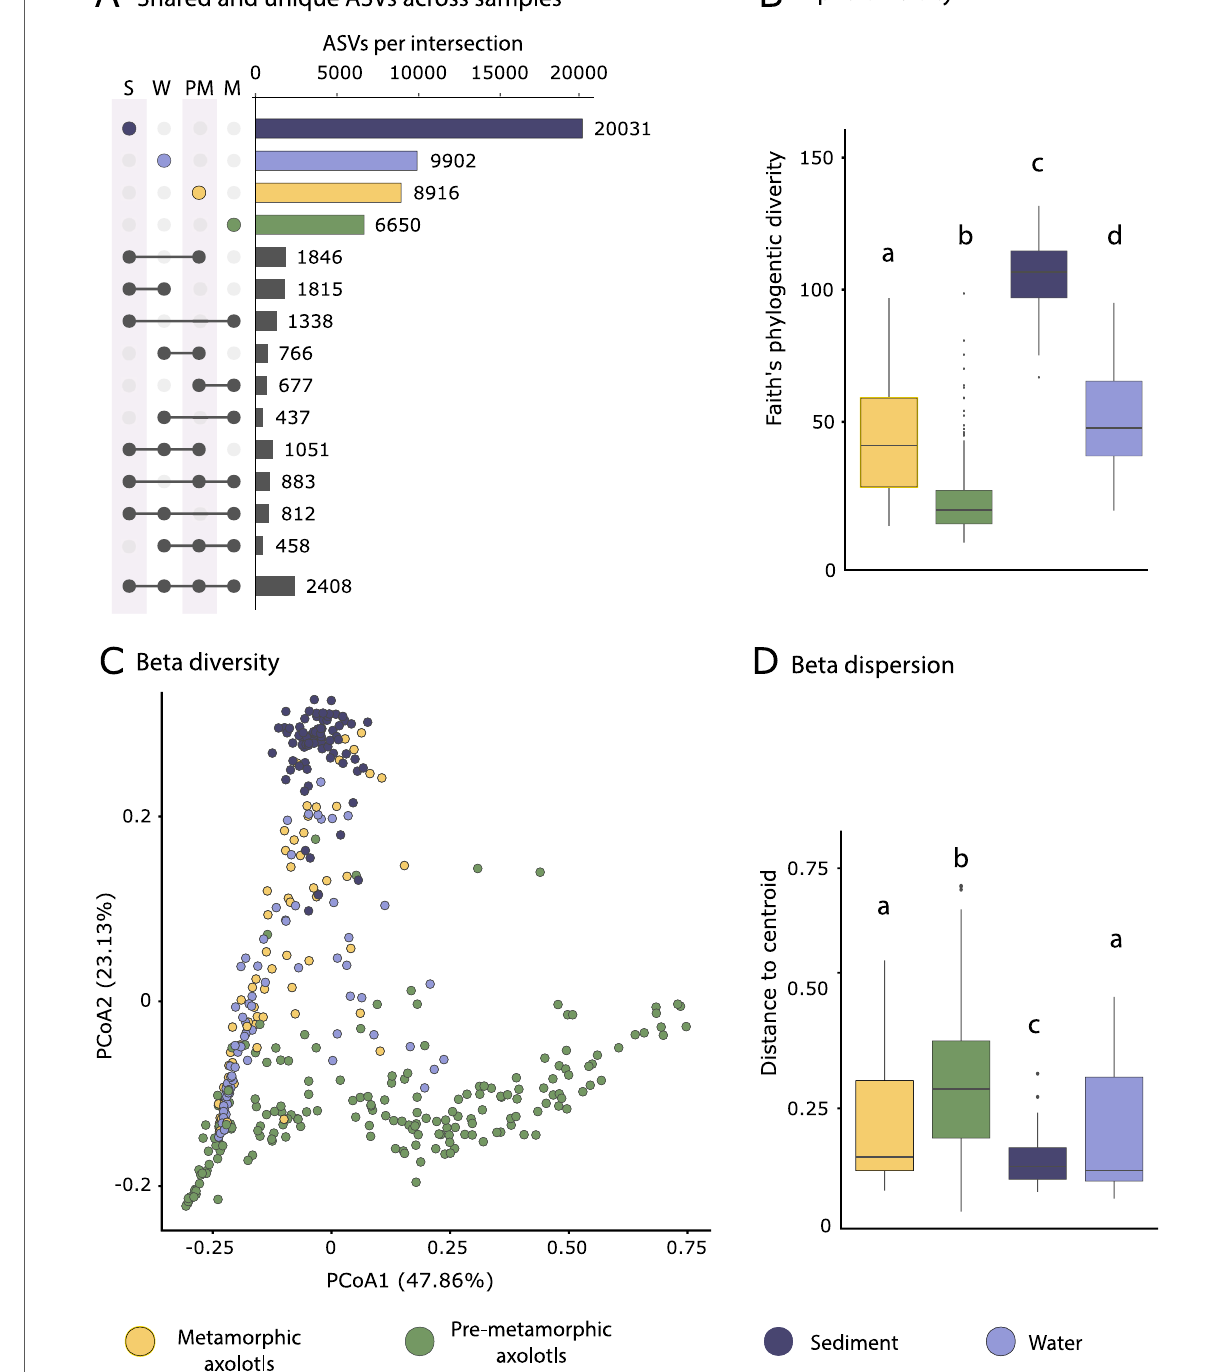
Fig. 1 Bacterial diversity of A. altamirani skin and environmental samples. A Upset plot illustrating the number of unique and shared ASVs. Numbers aside the color bars indicate how many ASVs were present on each sample type (color bars) and shared between sample types (gray bars). B Alpha Faith’s Phylogenetic diversity (PD) across sample types. C Principal coordinate analysis (PCoA) based on weighted UniFrac distances across sample types. D Beta dispersion using Analysis of multivariate homogeneity of groups dispersions. Letters a–d indicate statistically significant